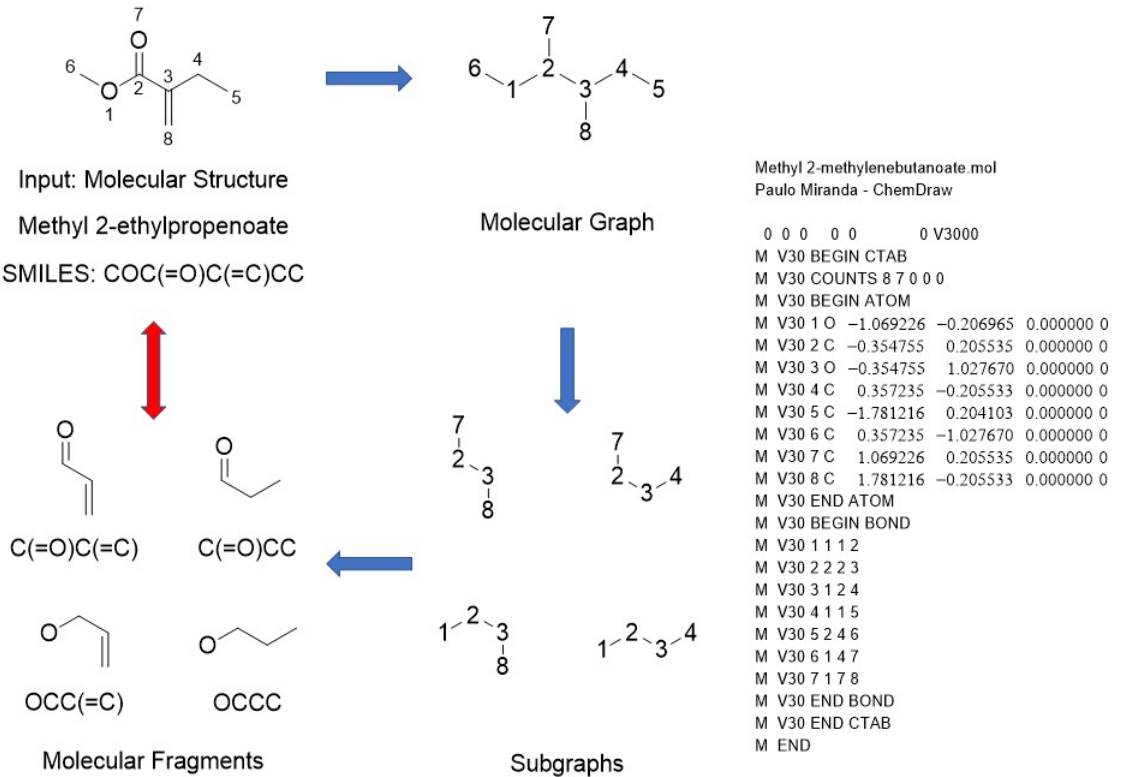
Figure 1. Molecular fragment generation. Molecular structure of methy l-2-ethylpropenoate (upper left), its molecular graph (upper center), Input file as mol format (right), subgraphs generated by Charming QSPR & QSAR (lower center), and the corresponding molecular fragments and SMILES notation (lower